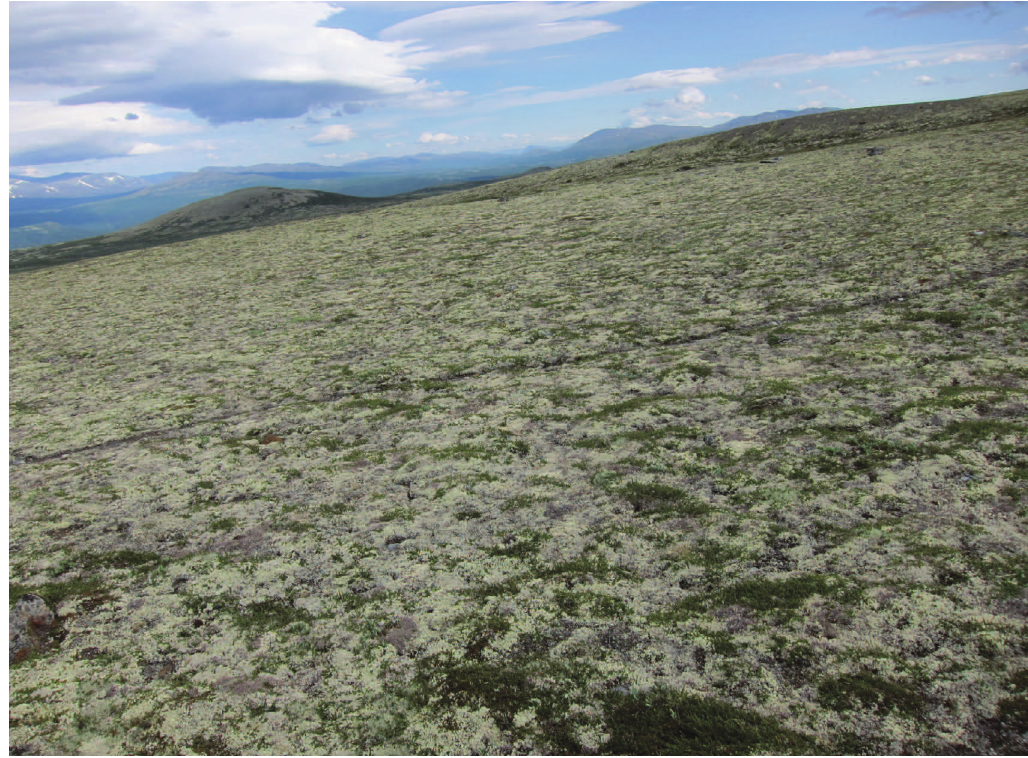
Figure 6. In continental areas with a gently sloping terrain where wind blows the snow away, large stands with a vegetation cover similar to Type A and B (Table 3) may occur. The picture is from the Vågå area, ca 1250 m